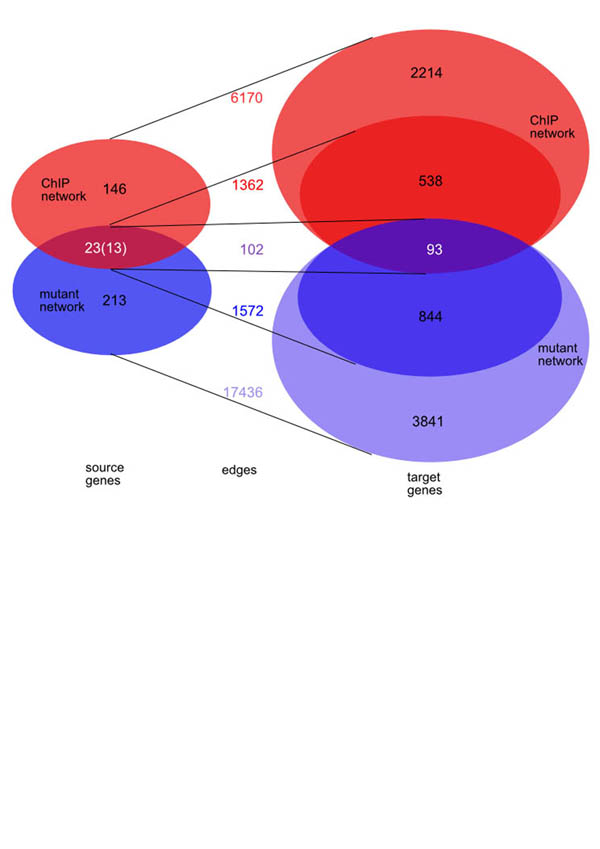
Venn diagrams of the intersection between the mutant and the ChIP network. The Venn diagram on the left hand side shows the intersection of the source genes between the mutant network and the ChIP network; the right hand side shows the intersections of the target genes between both networks. The connections between the two Venn diagrams indicate the corresponding number of edges. The networks share 23 source genes and 102 edges, but only 13 of the shared genes contribute to 102 shared edges, which connect to 93 distinct target genes. The 23 shared source genes are connected by 1362 edges to 631 target genes in the ChIP network and by 1572 edges to 937 target genes in the mutant network (see also Table 3).